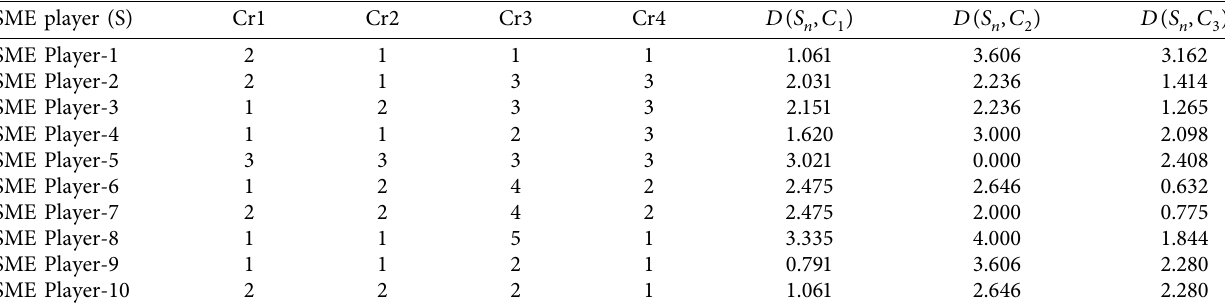
Table 19: Euclidean distance in the second iteration.